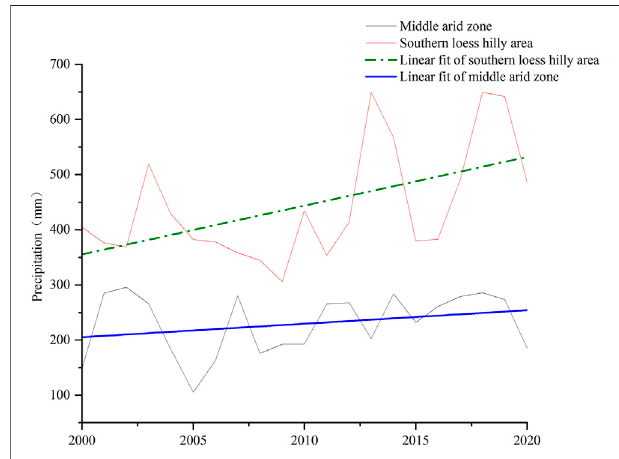
FIGURE 5 | Variation in precipitation in the middle arid zone and southern Loess hilly area along with the linear fi t.